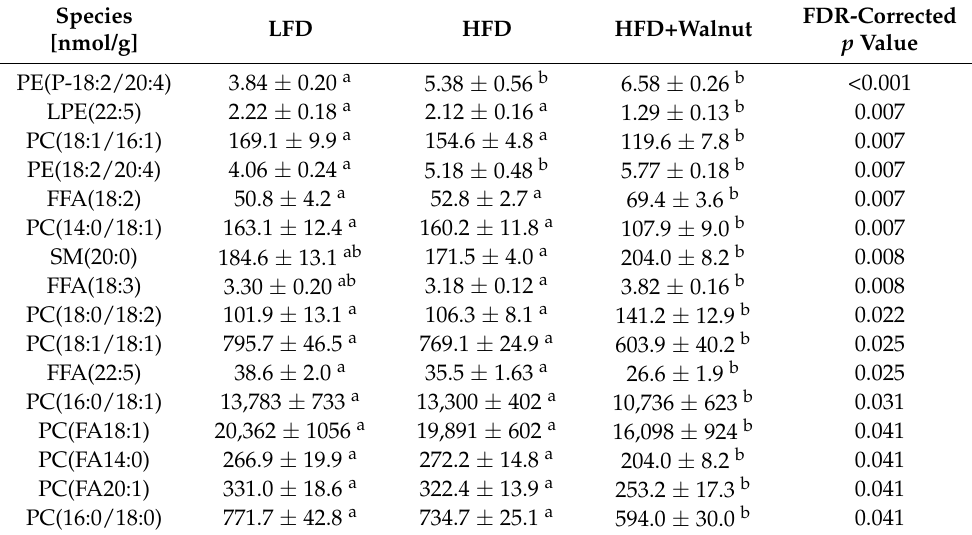
Table 1. Concentration of lipid species in hippocampus.